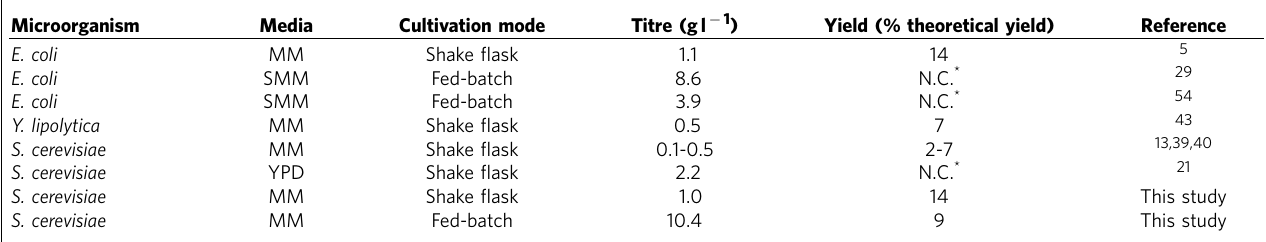
Table 1 | Comparison of cell factories for production of free fatty acids.